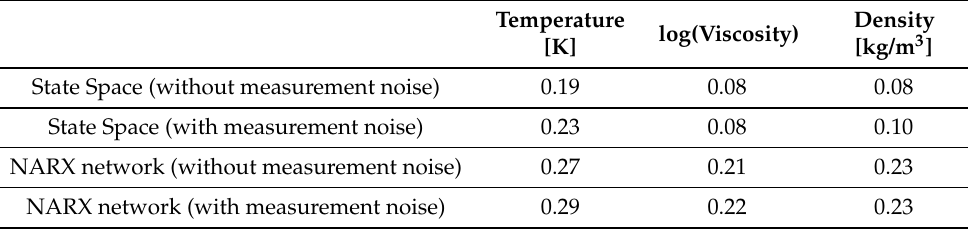
Table 2. Mean NRMSE evaluations for the validation of the identified